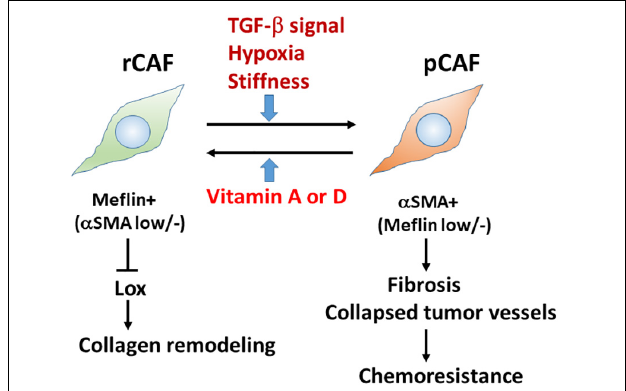
FIGURE 2 | Meflin is a new marker for restraining cancer-associated fibroblast (rCAFs) in pancreatic cancer. Recent evidence showed that Meflin + rCAFs, which suppress the activity of Lox and Lox-mediated collagen remodelling, differentiate into α SMA + pCAFs that are weakly positive or negative for Meflin and promote tissue fibrosis during cancer progression. TGF- β signalling, hypoxia, and stiffness are major factors that induce the phenotypic conversion of CAFs. Conversely, it has been hypothesised that vitamins A and D could reprogram pCAFs to